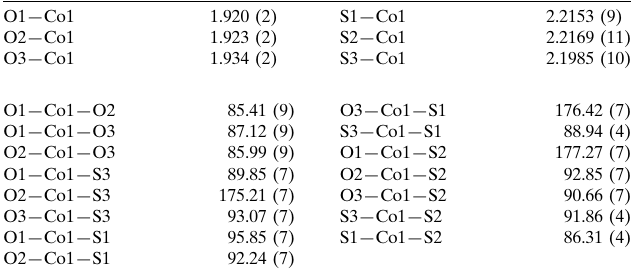
Selected geometric parameters (A˚ , (cid:1)